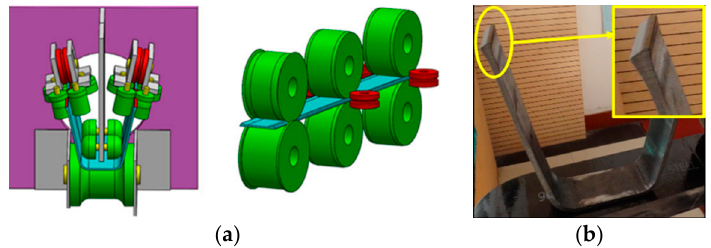
Figure 1. Illustration of thickened edge U-ribs: ( a ) fabrication process and ( b ) view.